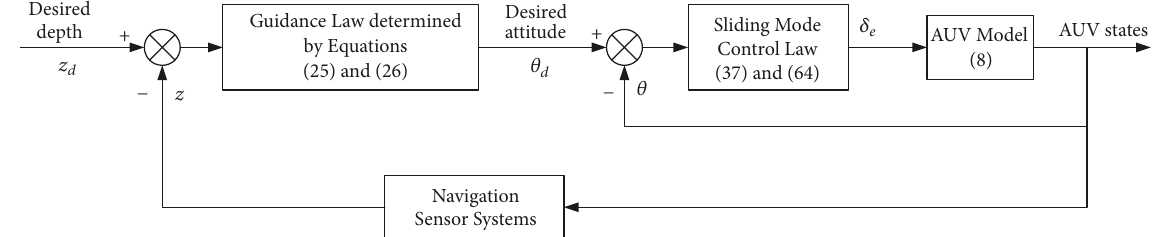
Figure 3: The structure of depth control